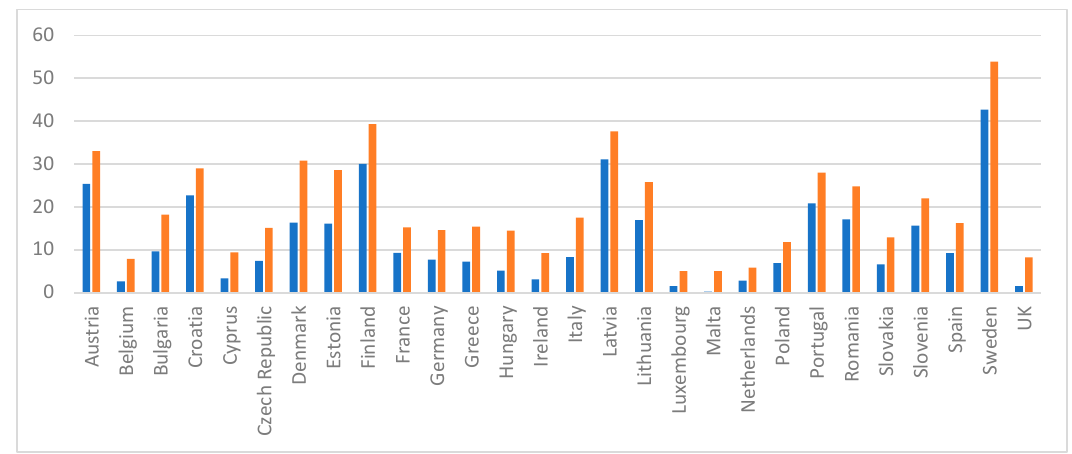
Figure 1. Share of renewable energy in final consumption in 2007 and 2017 in the EU-28 countries (blue-2007, orange-2017). Source: Own results.